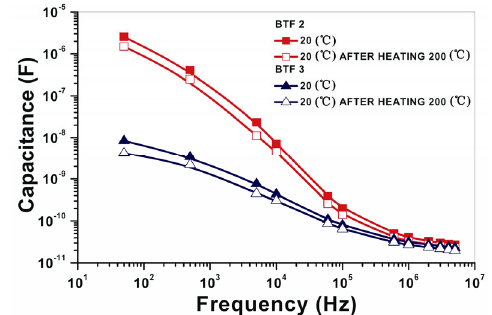
Fig. 10 Capacitance of the samples BTF2 and BTF3 versus frequency.